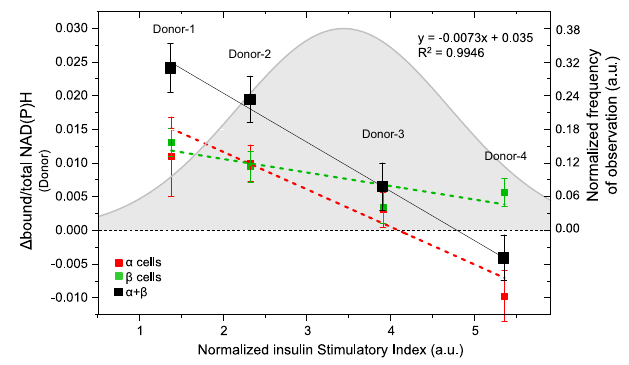
Fig. 4 coupling of FLIM metabolic data with ELISA-based insulin secretion assays. Donor-averaged metabolic shift of β cells (green points, n = 654 cells from 15 islets obtained by 4 different donors) always display a metabolic shift towards bound NAD(P)H, in accordance with present literature; by contrast, α cells averaged at donor level (red points, n = 312 cells from 15 islets obtained by 4 different donors) show a decreasing trend, progressively shifting from “ positive ” Δ bound/total NAD(P)H values to “ negative ” ones. In addition, the sum of α - and β -cell responses per each donor (black points) shows a markedly linear trend ( fi tting equation and R 2 coef fi cient reported in the graph legend). The gray curve represents the Gaussian fi tting of independently measured (thorough ELISA assays) insulin Stimulatory Index (normalized for insulin content) of n = 17 donors, whose detailed description in reported in Tab. S1. Data are presented as mean ±